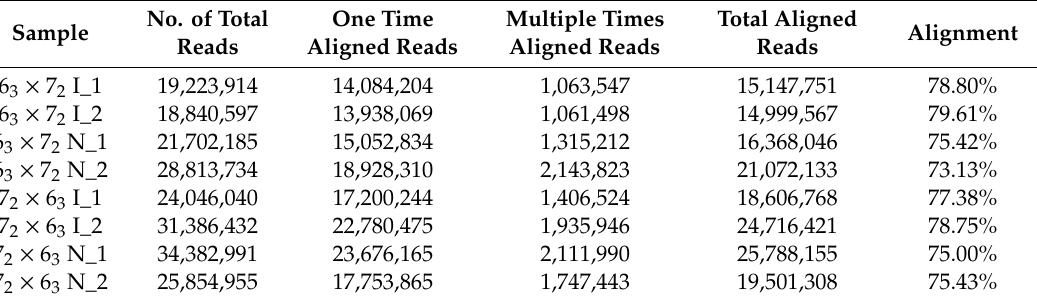
Figure 1. Experimental and data analyses designs. ( A ) Experimental design for identifying allele-specific expression (ASE) and differentially expressed (DE) genes based on high throughput sequencing (RNA-seq) using reciprocal crosses. ( B ) The pipeline of ASE and DE gene identification. The number on an arrow indicates the remaining genes after the previous step.